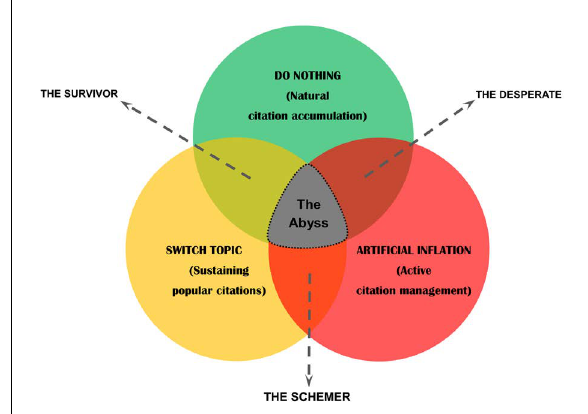
Four hypothetical scenarios that might arise when aspiring academics use combinations of tactics to increase quantitative performance metrics (adapted from concepts in Haley 5